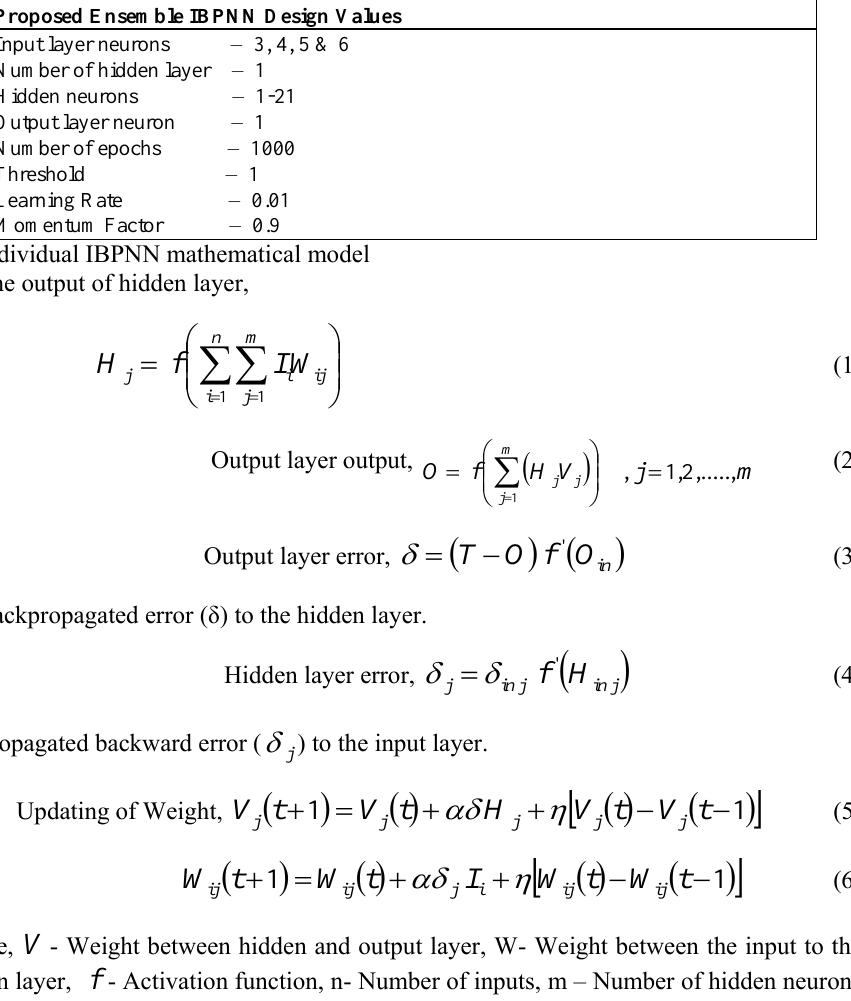
Table 1. Design Values of the proposed